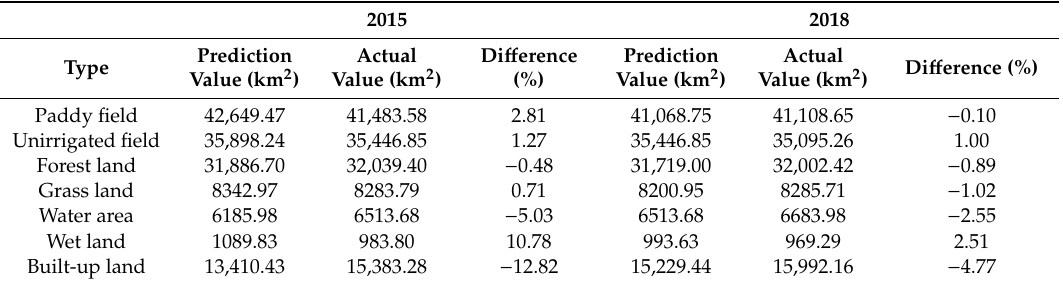
Table 9. Prediction results comparison of land use structure for 2015 and 2018.